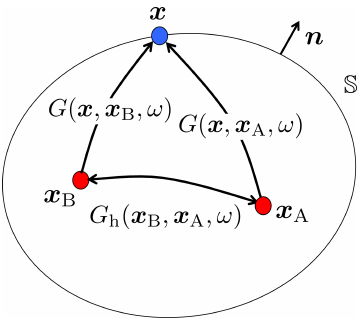
Figure 1. Configuration for the homogeneous Green’s function rep- resentation (Eq. 6). The rays in this and subsequent figures represent the full responses between the source and receiver points, including primary and multiple